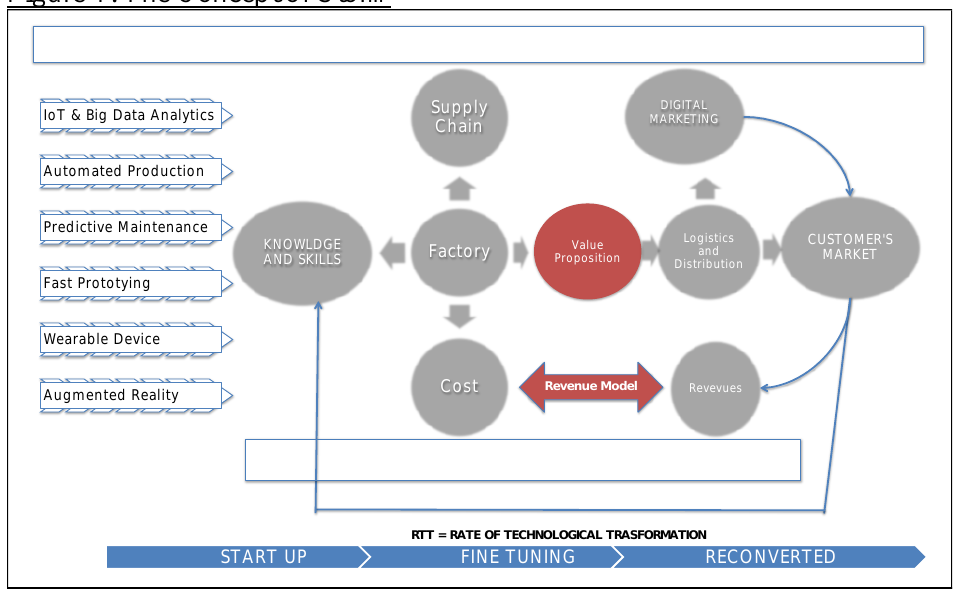
RTT = RATE OF TECHNOLOGICAL